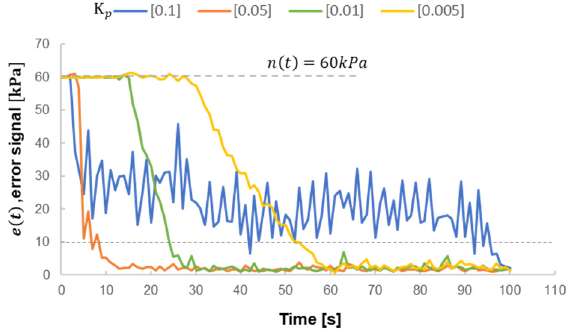
Figure 7. The changing trend of each error amount e ( t ), when target value n ( t ) is set to 60 kPa, and set PID parameter K p = 0.1, 0.05, 0.01, and 0.005.